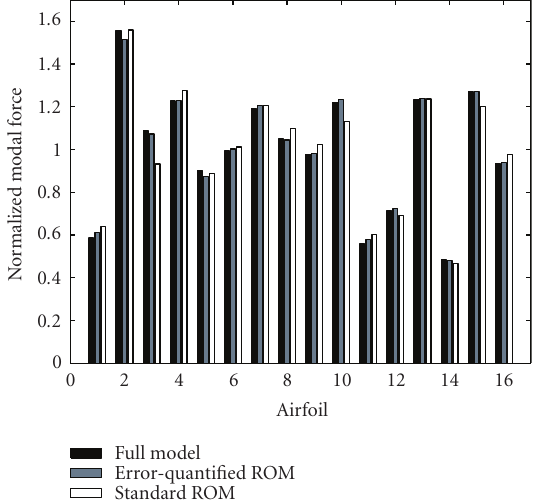
Figure 7: Maximum error calculation for airfoil frequency.